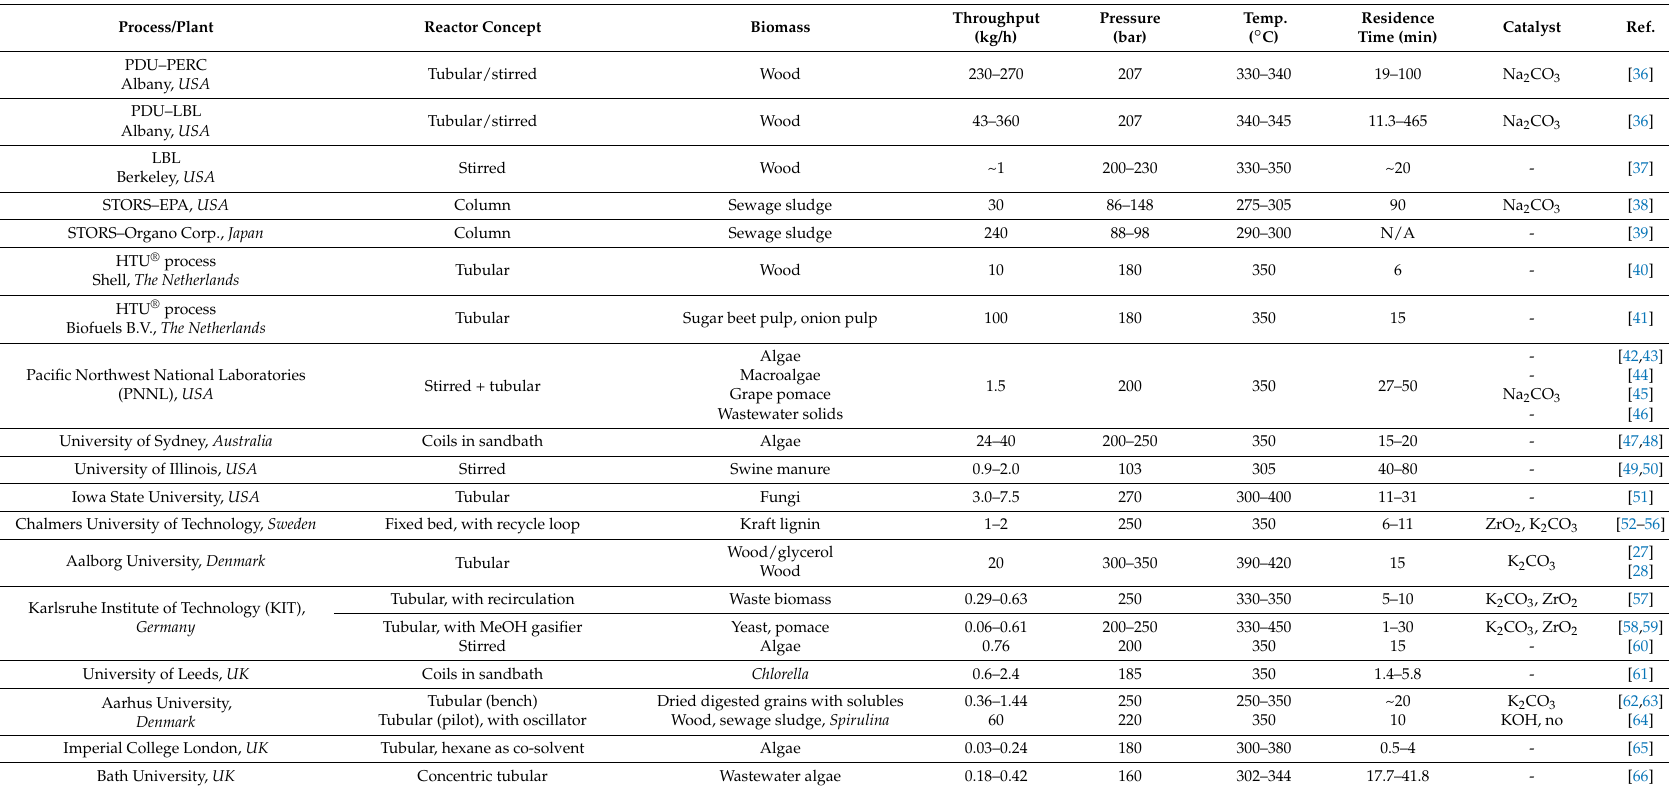
Table 1. Continuous hydrothermal liquefaction (HTL) plants and setups documented in the